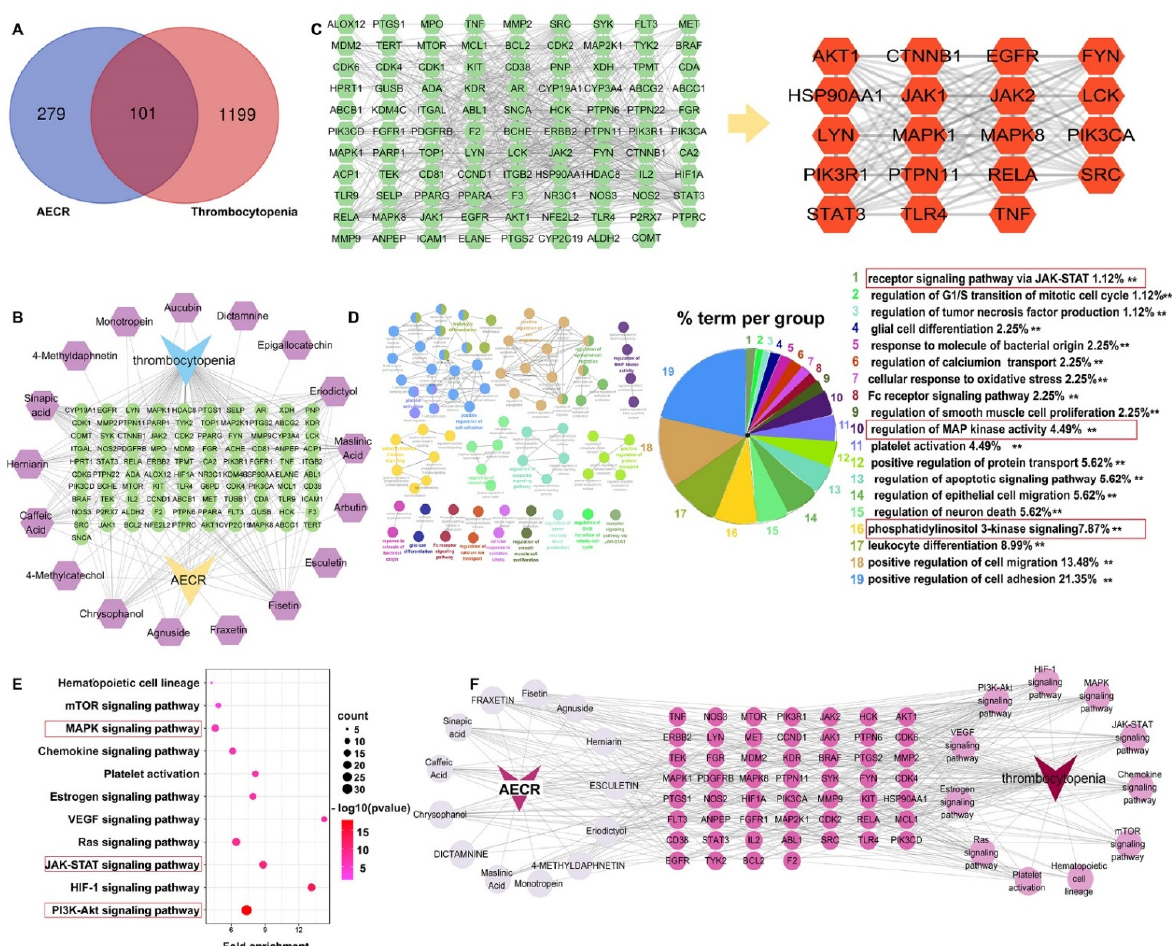
Figure 6. Network pharmacological prediction. ( A ) The Venn diagram of AECR targets and thrombocytopenia targets. Blue: AECR targets. Red: thrombocytopenia targets. Pink: common targets. ( B ) The AECR–ingredient–target–thrombocytopenia network. ( C ) The PPI network shows the targets of AECRs against thrombocytopenia with a combined score of >0.7, a degree of ≥ 23, a BC of ≥ 0.004028, and a CC of ≥ 0.443925. ( D ) GO enrichment analysis ( p < 0.01). ( E ) Bubble plot of 11 KEGG pathways of AECRs in the treatment of thrombocytopenia. Greater enrichment is reflected in a larger fold enrichment. The size of the bubble represents the number of enriched genes in each pathway. The color of the bubble represents the Log10 range ( p ‐ value). ( F ) The AECR–ingredient–target–thrombocytopenia pathway network. “**” stands for p < 0.01. AECRs: aqueous extracts of Cibotii rhizoma .